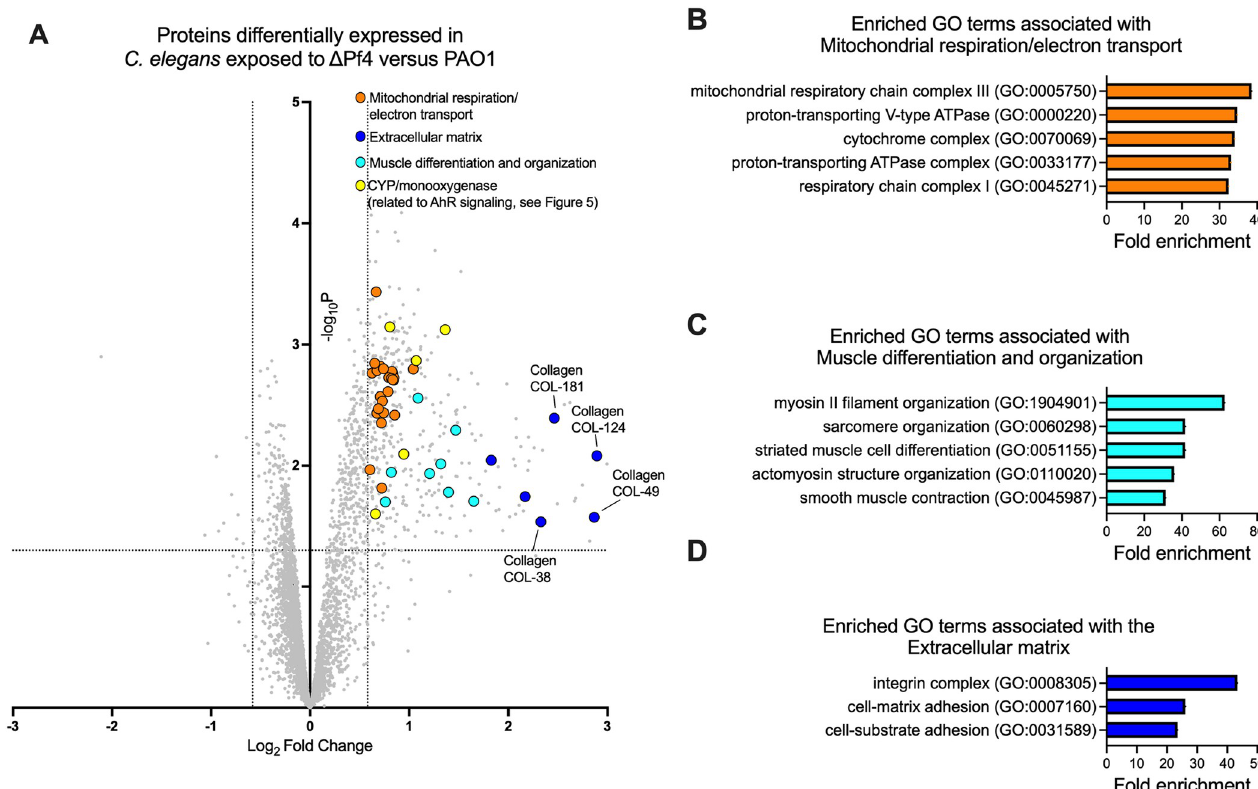
Fig 4. Pf4 modulates expression of C . elegans proteins associated with respiration, the extracellular matrix, and motility. (A) Volcano plot showing differentially expressed proteins in C . elegans maintained on lawns of Δ Pf4 compared to C . elegans maintained on lawns of PAO1 for three days. The dashed lines indicate proteins with expression levels greater than ± 1.5-fold and a false discovery rate (FDR) < 0.05. Results are representative of quadruplicate experiments. (B-D) Enrichment analysis of significant upregulated proteins shown in (A). Fold enrichment of observed proteins associated with specific Gene Ontology (GO) terms each had an FDR of <